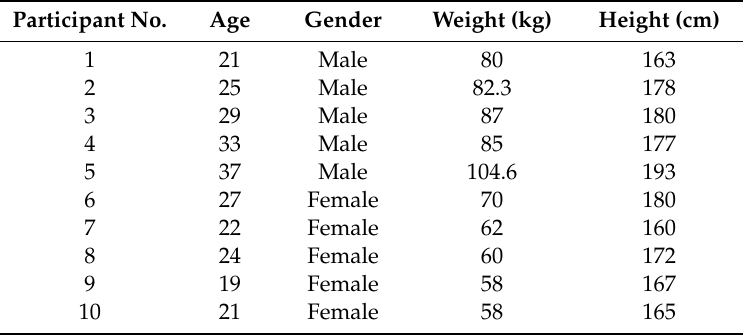
Table 6. Information about gender, age, height and weight of the participants. Participant